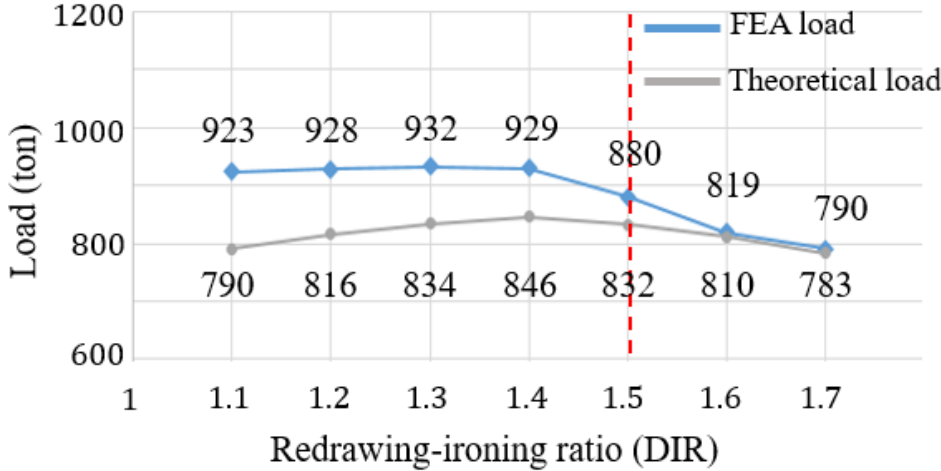
Figure 14. Comparison of the combined redrawing-ironing load obtained from FEA and that of theoretical formula by varying DIR. Table 5. Error between combined loads obtained from FEA and theoretical formula according to DIR.